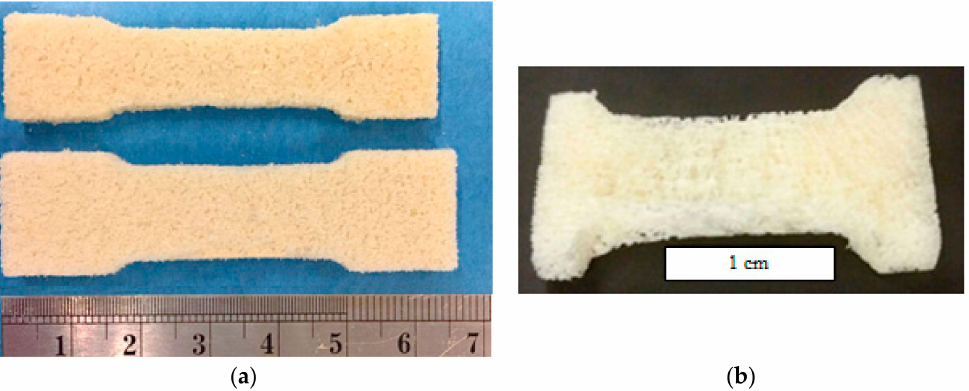
Figure 4. Example of tensile bar built by laser sintering (LS) used in Ultimate Tensile Test (UTS) measurements. ( a ) The tensile bar built by Laser Sintering (LS). Bottom: green body; top: the